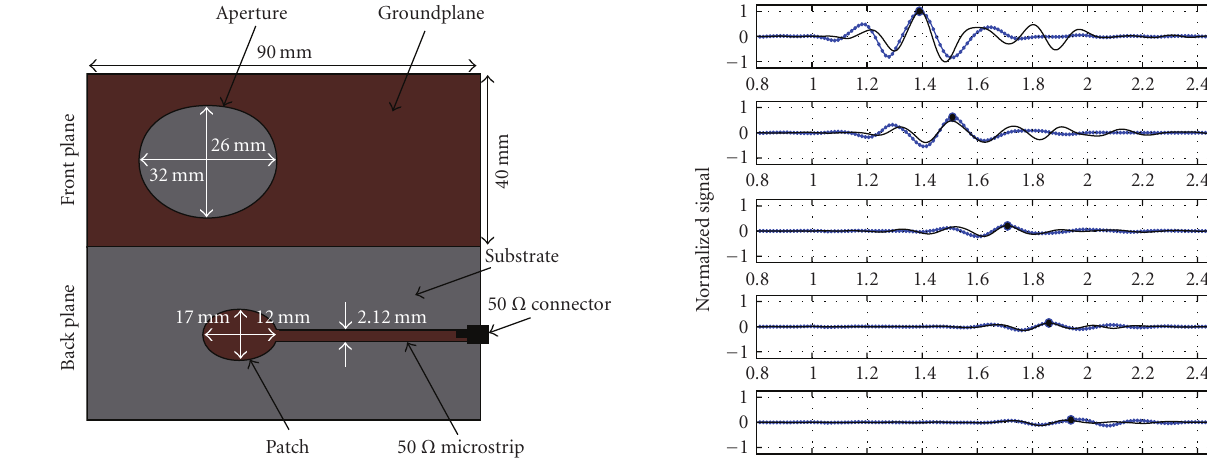
Figure 4: Antenna layout of UWB elliptical antenna used in the microwave imaging system.